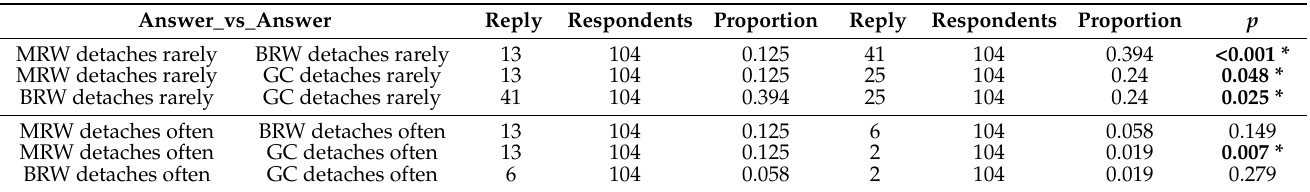
Table 5. Distribution of the opinions on which wire rarely debonds from the teeth.